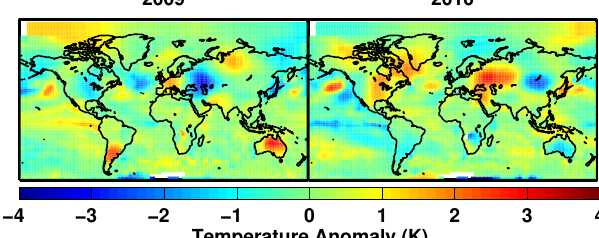
Fig. 4. The August surface temperature anomalies from GISS for 2009 (left) and 2010 (right) in degrees Kelvin. The Northern Hemi- sphere 2010 temperatures are significantly warmer than those in